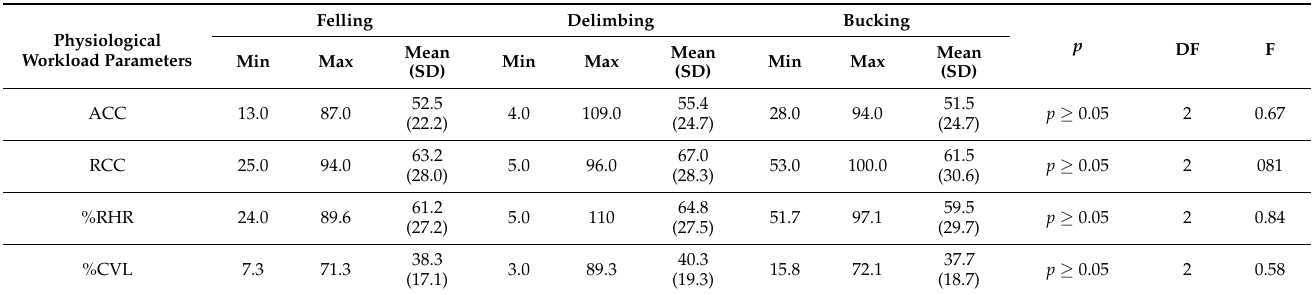
Table 4. Comparison, across 40 loggers of absolute cardiac cost, relative cardiac cost, and relative heart rate, for felling, delimbing, and bucking tasks.